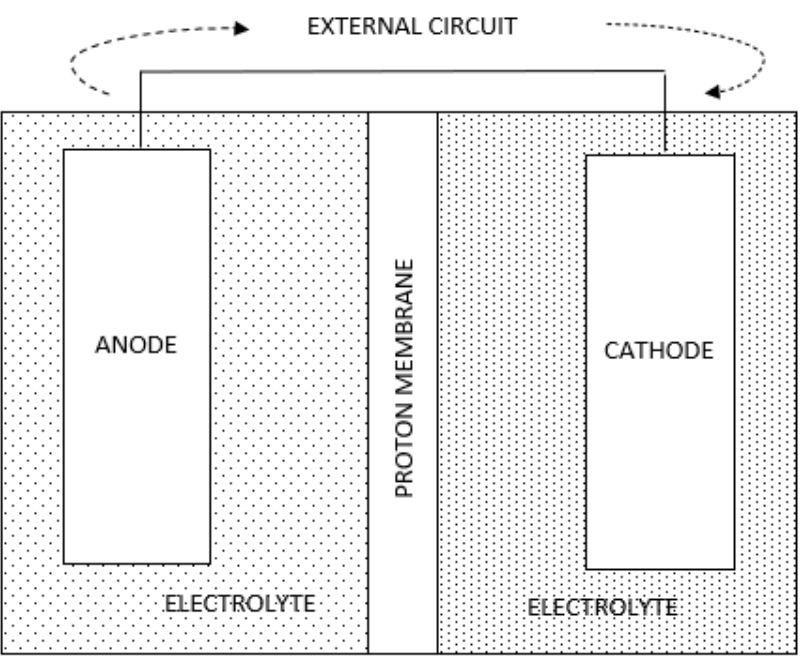
Figure 3. A basic fuel cell .